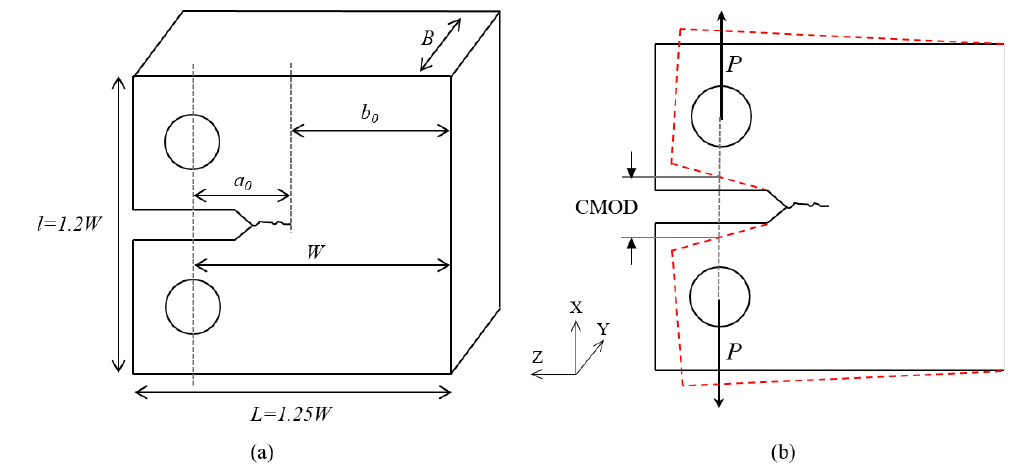
Figure 3. Geometry of a CT specimen ( a ) and crack mouth opening displacement ( b